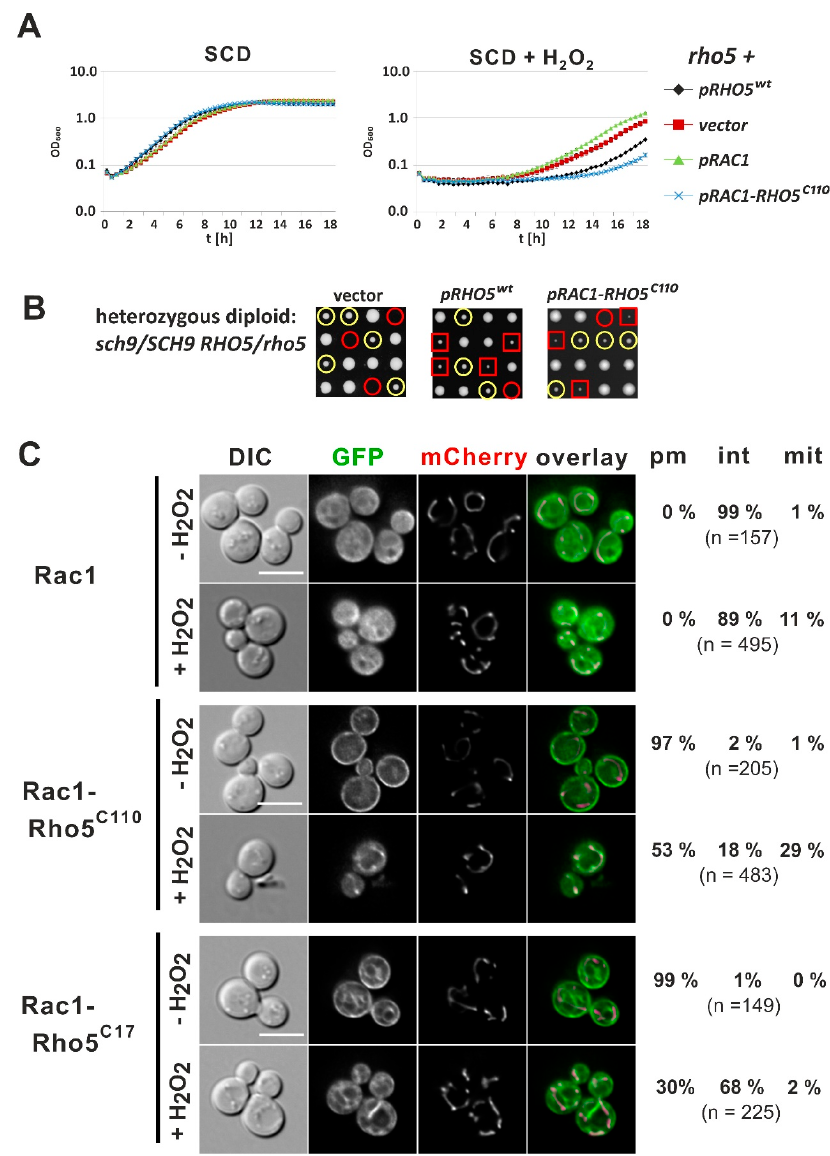
Figure 6. Growth and response to oxidative stress of yeast strains producing human Rac1 and its derivatives. ( A ) Comparative growth behavior of transformants of a rho5 deletion (HAJ216-A) expressing the indicated GTPase variants from a centromeric vector. Plasmids introduced were YCplac111 (vector), pJJH1637 ( pRHO5 wt ), pLAO4 ( pRAC1 ), and pCSO85 ( pRAC1-RHO5 C110 ; see Table 2). ( B ) A heterozygous diploid obtained by crossing HAJ216-A ( rho5 ) with HAJ195-A ( sch9 ) was used as a recipient for the plasmids described in ( A ), with omission of pLAO4, and transformants were subjected to tetrad analyses. Yellow circles highlight segregants with a sch9 deletion only, red circles non-viable segregants with the genotype rho5 sch9 , and red squares designate double deletion segregants rescued by the plasmid-borne gene copy. ( C ) Life-cell fluorescence microscopy of a rho5 deletion strain producing Idp1-mCherry as a mitochondrial marker (HCSO76-1A) and N-terminal GFP fusions of the Rac1 variants indicated, expressed from a CEN / ARS vector. Plasmids employed were pLAO6 (Rac1), pCSO89 (Rac1-Rho5 C110 ), and pCSO100 (Rac1-Rho5 C17 ). See Table 2 for more information on the plasmid features. For detailed descriptions of growth conditions, scales, and determination of distribution numbers see legend of Figure